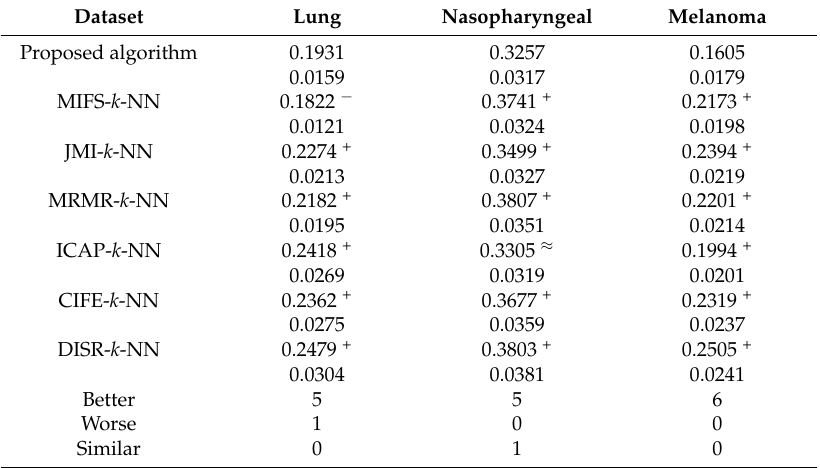
Table 6. Average error rate of individual filter algorithms and proposed